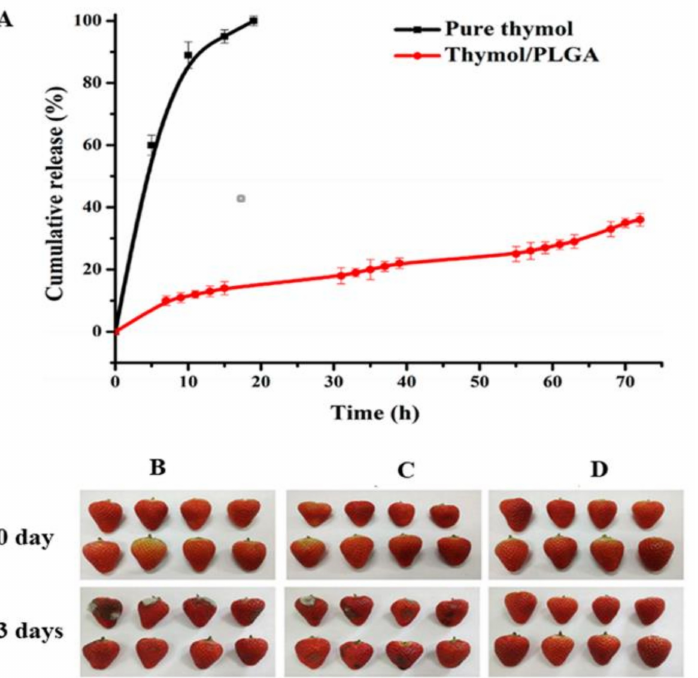
Figure 7. ( A ) Analysis of the release of nanofiber-encapsulated thymol and pure thymol. ( B – D ) Pictures of strawberries processed for 0 and 3 days: ( B ) Control, ( C ) strawberries packed with PLGA nanofiber film, and ( D ) strawberries packed with thymol/PLGA nanofiber film. Adapted from [125] with copyrights permission fromfrom the American Chemical Society.